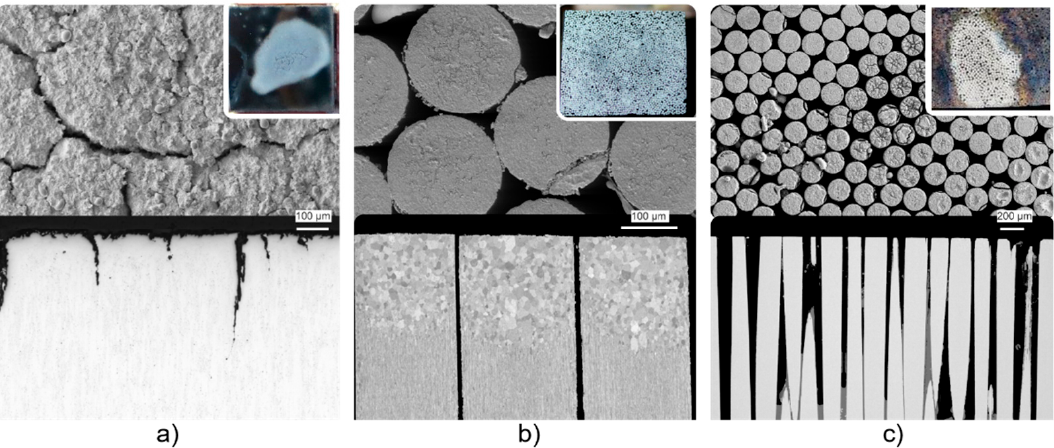
Figure 5. Surface (upper) and cross section (lower) of bulk W reference after 10 5 transients ( a ) and W-Cu µ-brush joined by Cu infiltration after ( b ) 10 5 and ( c ) 10 6 transients. The insets show a top-view picture of the whole sample.